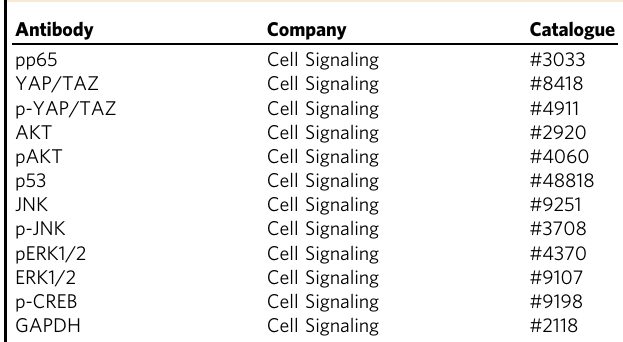
Table 2 List of primary antibodies